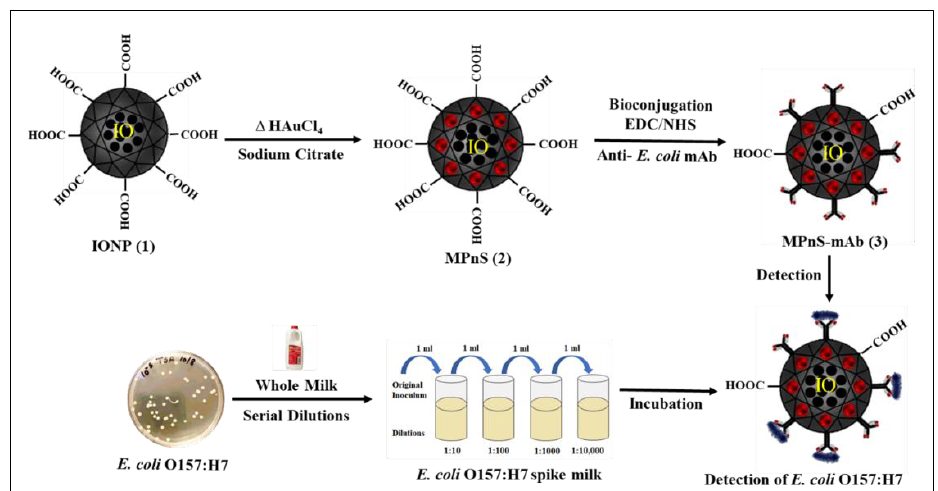
Scheme 1. Schematic illustration of synthesis of magneto-plasmonic nanosensor (MPnS) and its conjugate for the multiparametric detection of E. coli O157:H7.